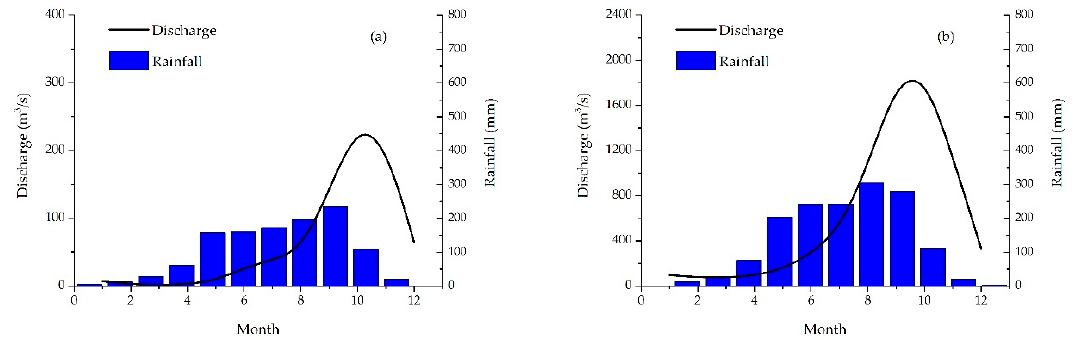
Figure 3. Variations of monthly average flow discharge at CHUMPHON (CH) ( a ) and UBON (UB) ( b ) stations during 1980–2018 in line with the variations of monthly average rainfall in the Mu River basin.